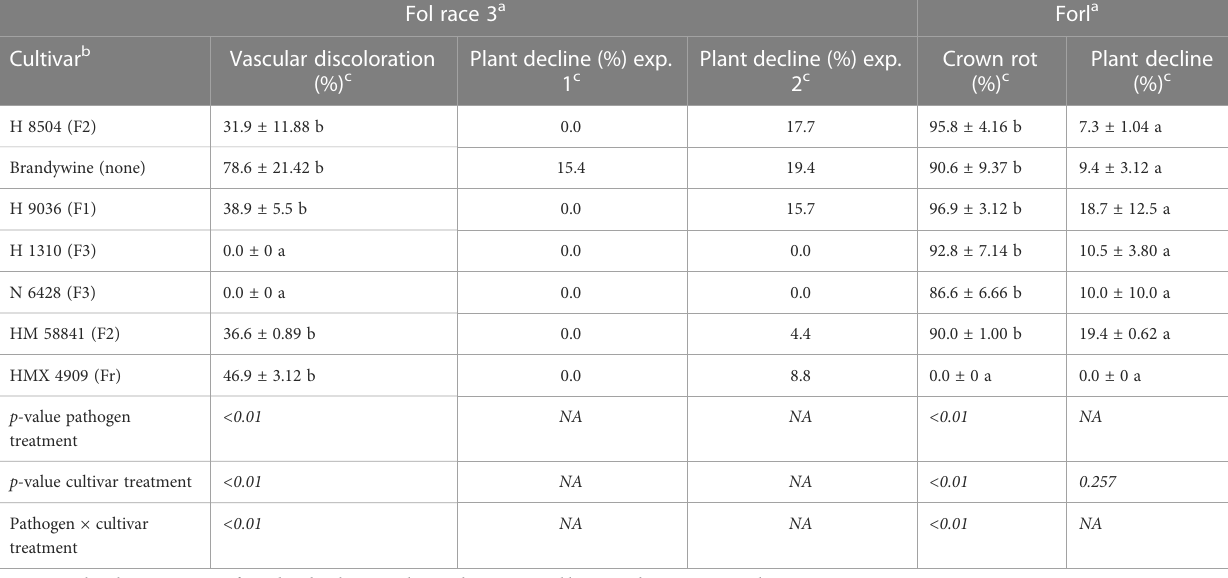
TABLE 4 Phenotyping with a young plant tray assay of seven tomato cultivars inoculated with different formae specialis of Fusarium oxysporum .